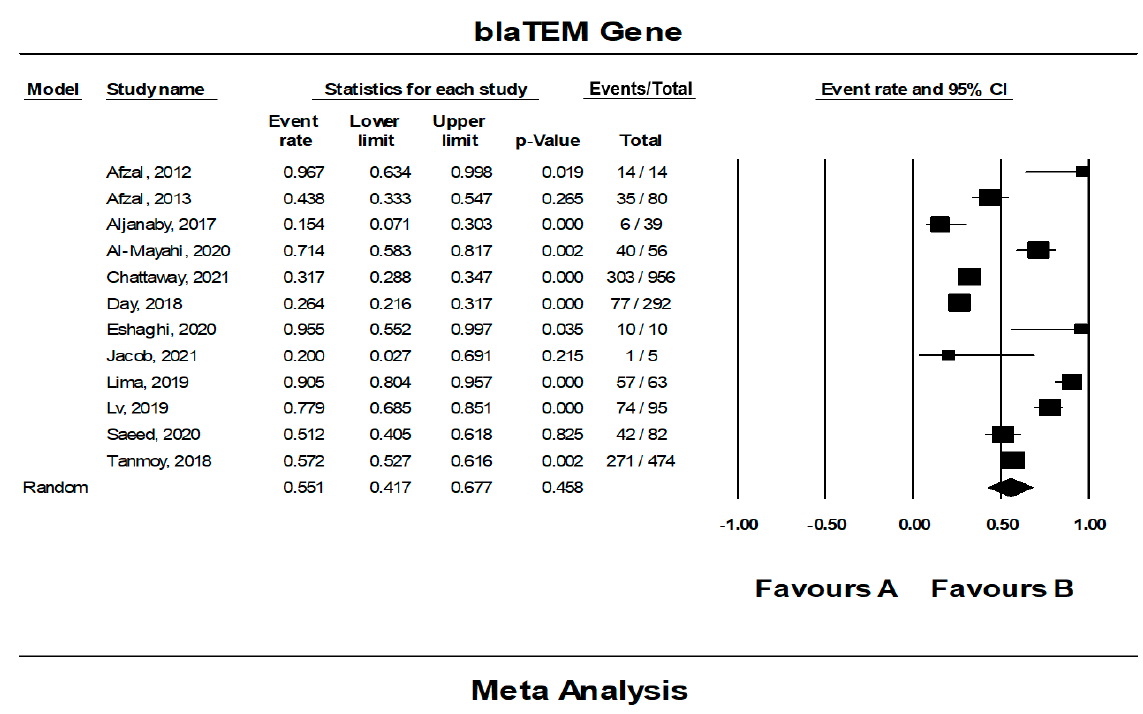
Figure 13. Forest plot showing the pooled prevalence of bla TEM gene in resistant S. Typhi isolates estimated by a random-effect model of meta-analysis. (55.1%, I 2 : 95.27, 95% CI: 41.7–67.7, p -value < Table 7. Sub-group analysis of prevalence bla TEM gene in S. Typhi according to countries and regions.